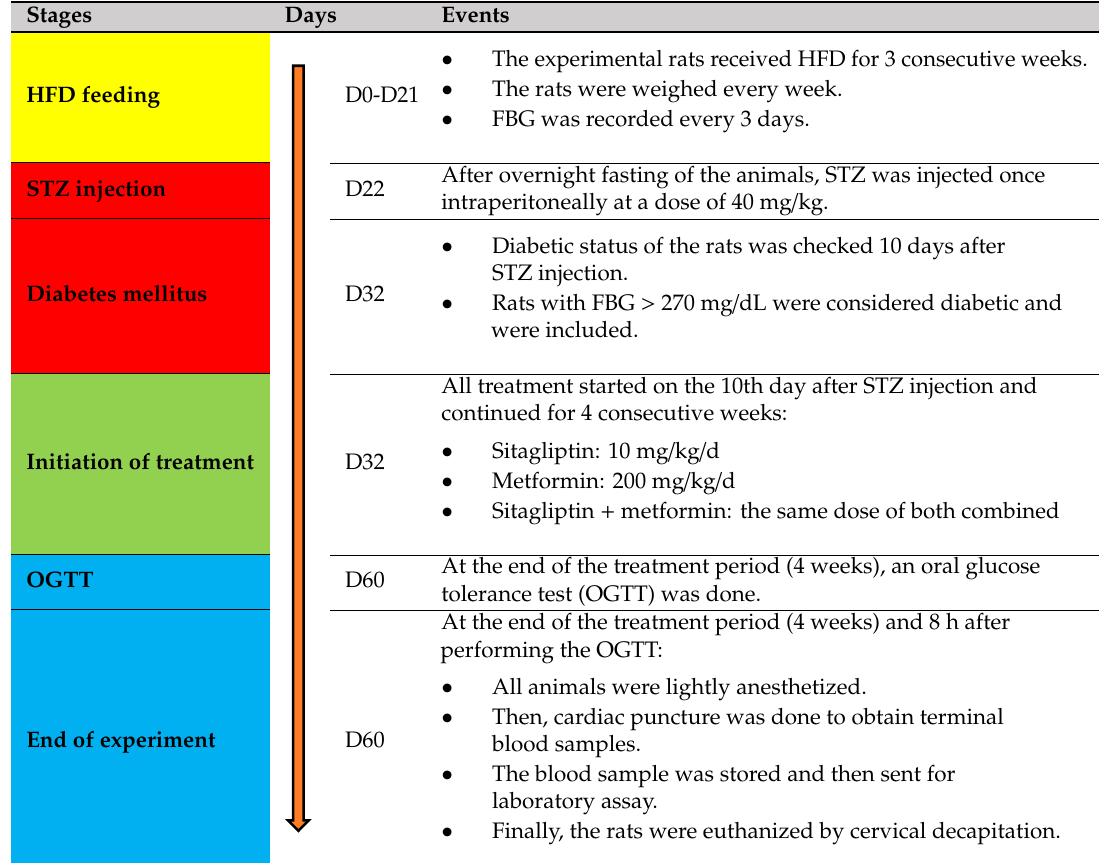
Table 1. Illustration of the workflow of the study.